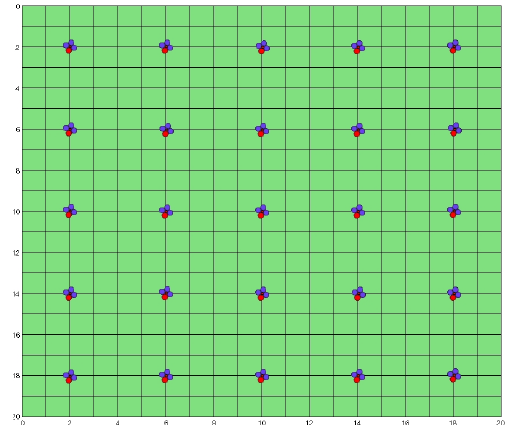
Figure 4. The test area (400 locations arranged in a 20 (cid:2) 20 grid) and the 25 UAVs in homogeneous swarm formation.